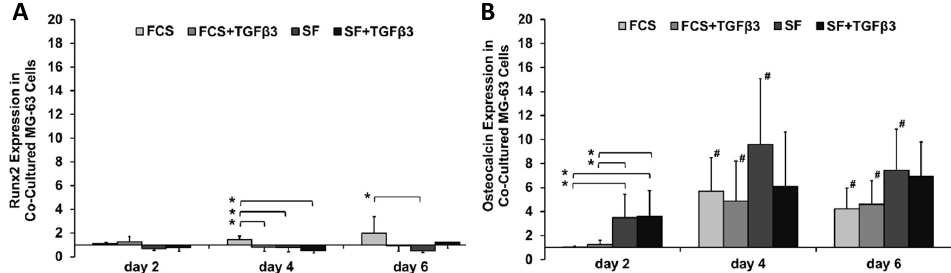
Figure 1. Fold-change in relative gene expression for ( A ) Runx2 (CT: 18–22) and ( B ) osteocalcin (CT: 18–24) in co-cultured MG-63 osteoblast-like cells. Gene expression levels were normalized to GAPDH and were made relative to cultures in αMEM + FCS on day 2. The dCT data was used for statistical analysis: normally distributed, one-way ANOVA with Tukey ( n = 3–4 replicates/experiment, 3 experiments). Statistical significance was determined as p < 0.05; *: compared to different media on that day; #: compared to same medium group on day 2. Bar charts show the average fold-change as well as the standard error of the mean.